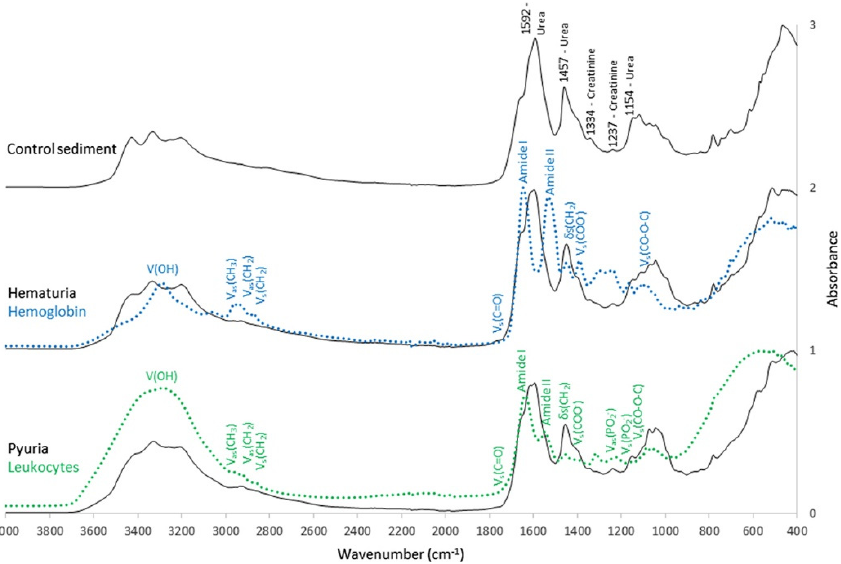
Figure 2. Mean normalized infrared (IR) spectra of urinary sediment of control subjects, patients with hematuria, and patients with pyuria. Distinctive peaks were present at 1592 cm −1 (urea), 1457 cm −1 , (urea), 1334 cm −1 (creatinine), 1237 cm −1 (creatinine), and 1154 cm −1 (urea). The amide I (1655 cm − 1 and amide II (1525 cm −1 ) bands were overlapping in the region from 1510 to 1750 cm −1 . A dried suspension of hemoglobin (blue line) and isolated leukocytes (green line) was added to the figure. Typical molecular assignments of a biological IR spectrum were indicated on the IR spectra of hemoglobin and the leukocytes: V = stretching vibrations; δ = bending vibrations; s = symmetrical vibrations and as = asymmetrical vibrations. Picture reproduced with permission from “ Exploring the possibilities of infrared spectroscopy for urine sediment examination and detection of pathogenic bacteria in urinary tract infections. Steenbeke, M. et al., Clinical Chemistry and Laboratory Medicine [65]